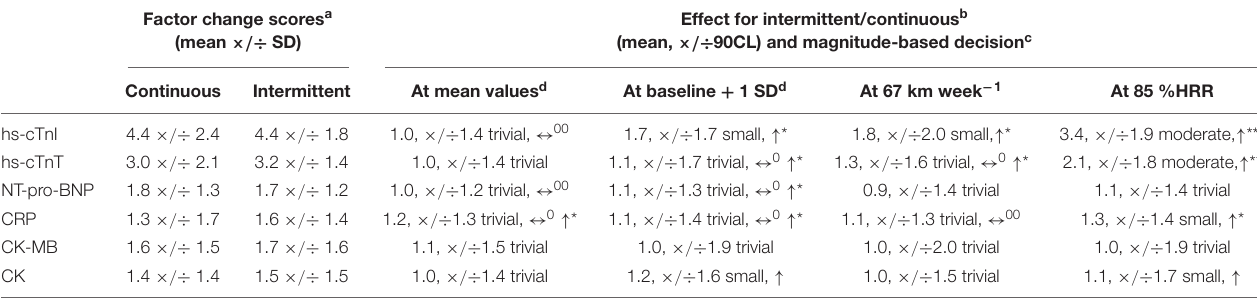
TABLE 2 | Changes in concentration of biomarkers following continuous and intermittent exercise, with magnitude-based decisions for the comparison of the changes adjusted to mean values of potential modifiers and to 1 SD above baseline concentration, to approximately 1 SD above mean Tvol (67 km week − 1 ), and to approximately 1 SD above mean exercise intensity (85%